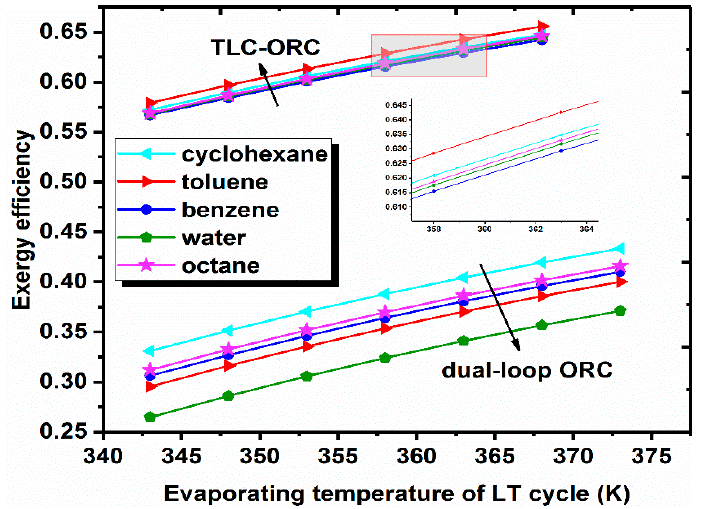
Figure 10. Comparison of exergy efficiency between the two configurations under different LT cycle evaporating temperature.